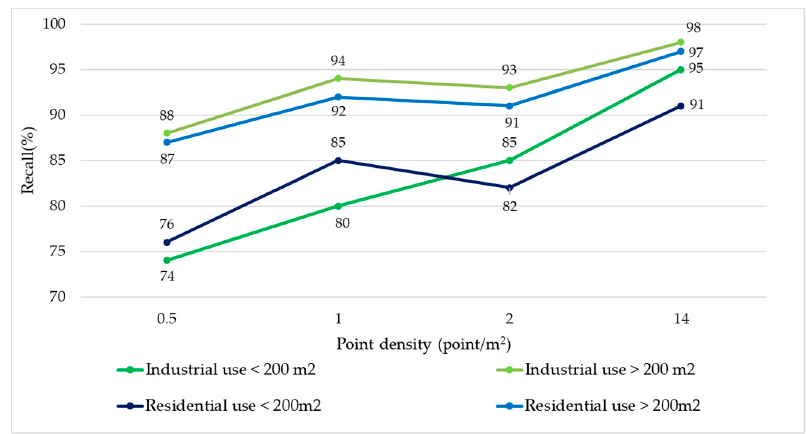
Figure 10. Recall (%) for the different the point cloud densities depending on the use of the building and the area of the roof.